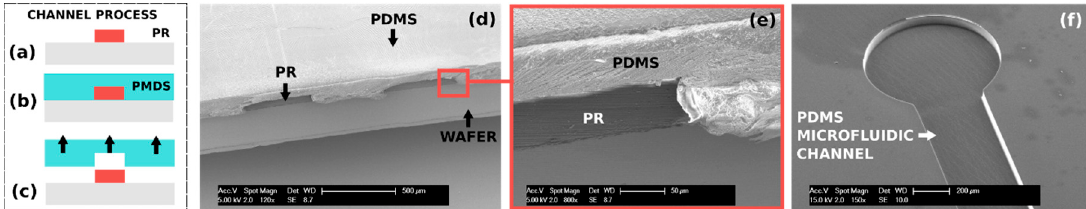
Figure 2. Process flow applied for the fabrication of microfluidic channel: ( a ) PR is deposited and patterned on a silicon wafer, ( b ) PDMS is molded on top of the PR structures with the presented process and ( c ) the PDMS structure is peeled-off from the wafer. ( d ) SEM images of the 100 µm thick photoresist (PR) structures embedded in a 200 µm thick PDMS layer. ( e ) Close-up of the PR structures covered with PDMS. The PDMS conformally covered the vertical walls of PR, thus retaining the predefined geometry. The microfluidic channels were created by peeling off the PDMS layer ending up with the photoresist pattern imprinted on the back of the PDMS layer ( f